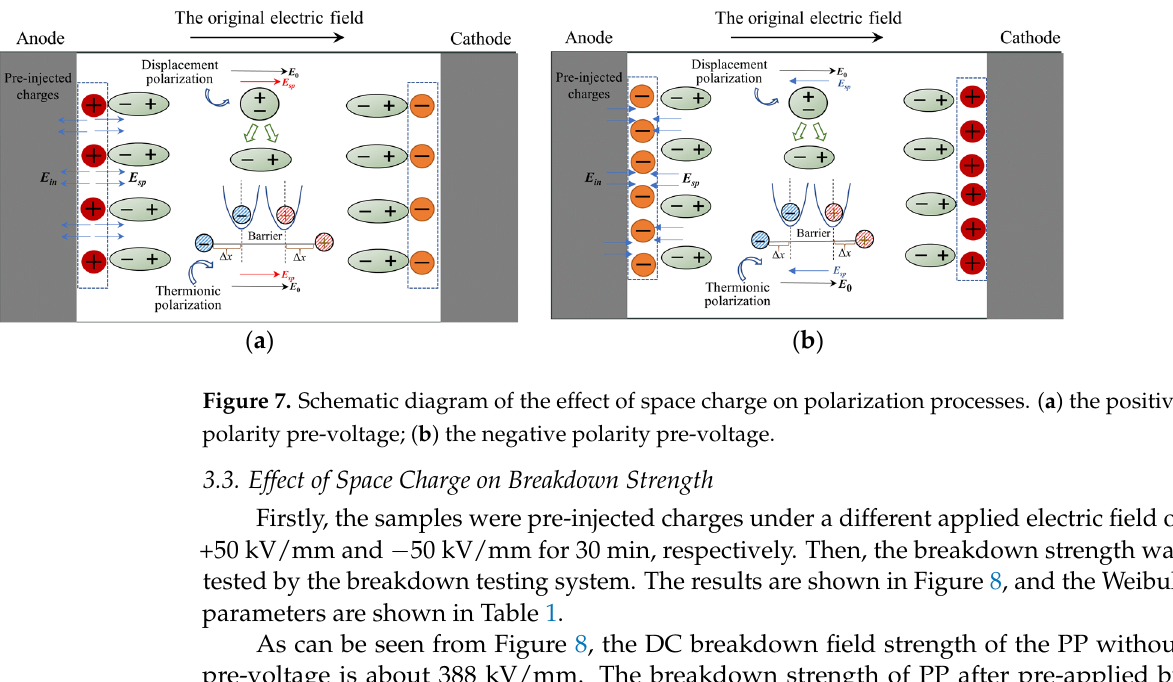
Figure 6. Infrared spectra of PP before and after pre-applied voltage.